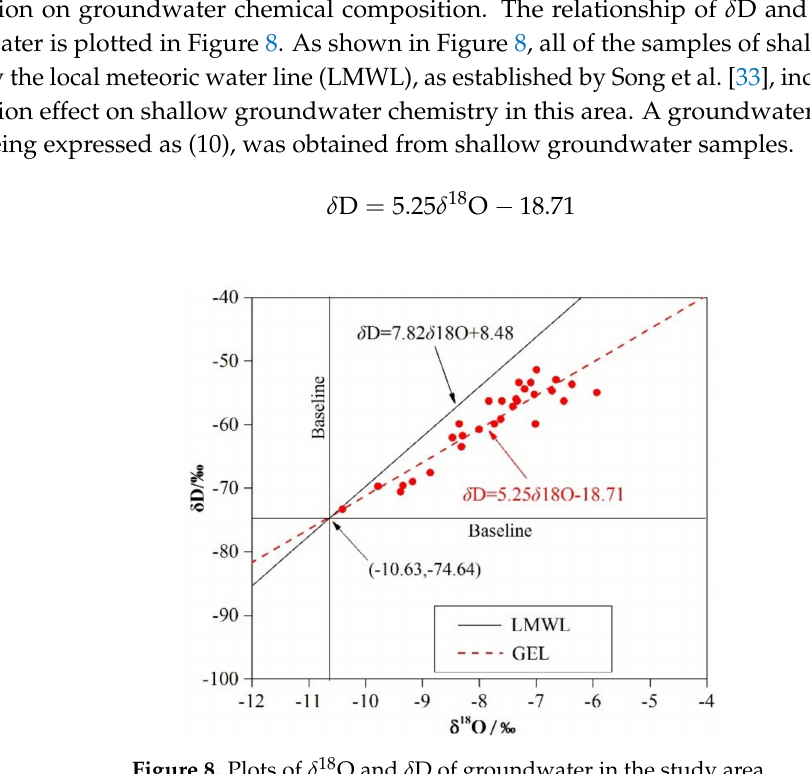
Figure 8. Plots of δ 18 O and δ D of groundwater in the study